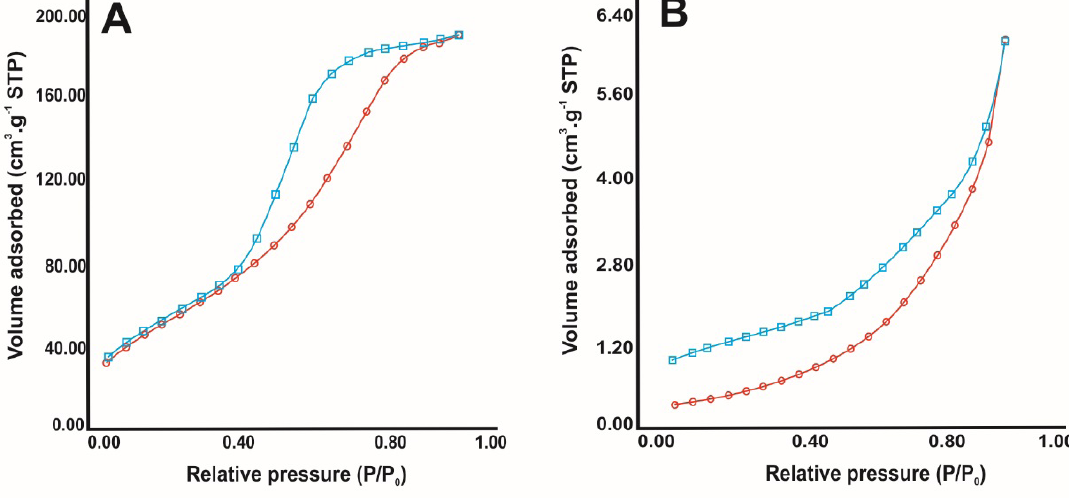
N]-20; (B) A-mbmim[Tf 2